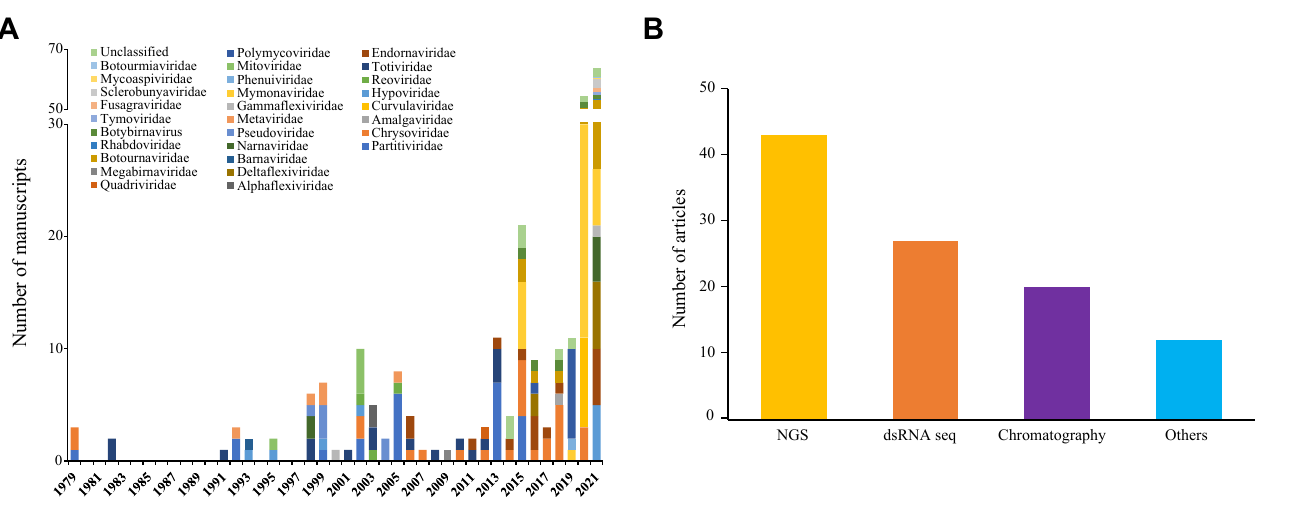
Figure 5. Overview of mycoviruses identification. ( A ) Abundance and family of viruses identified by year. ( B ) Strategy applied to mycovirus